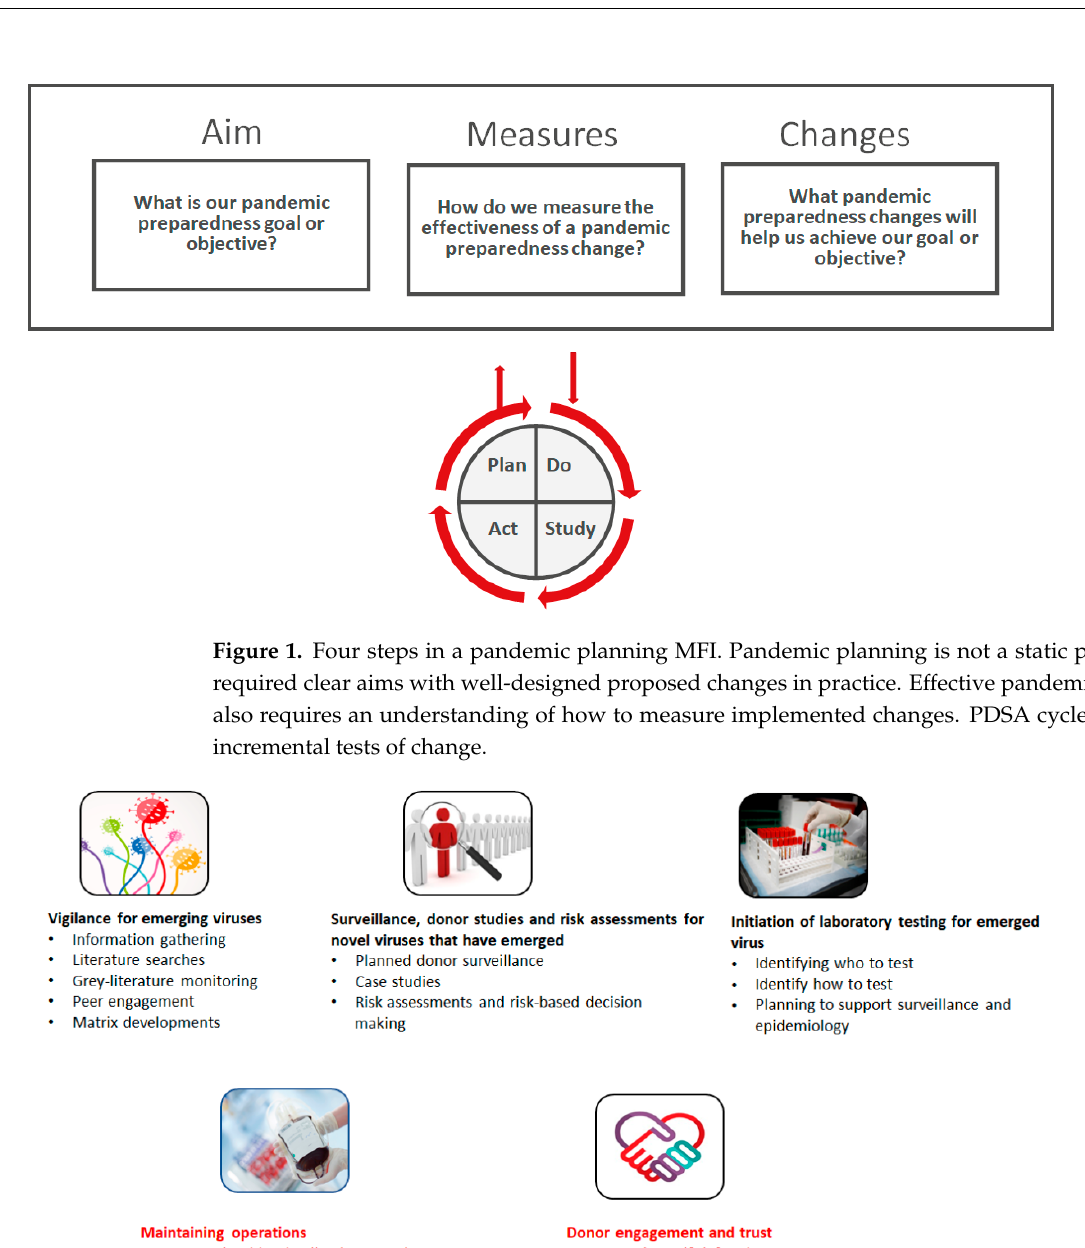
Figure 2. Activities that support pandemic preparedness. To ensure the safe supply of blood products, blood operators undertake complex activities on a routine basis. Pathogen-specific areas of focus (black text) include vigilance for emerging viruses, surveillance, donor studies and risk assessments for viruses that have emerged and initiating laboratory testing for emerging viruses. Core activities to ensure the adequate supply of blood products (red text) include donor engagement and trust, and maintenance of operations. Individuals working in blood operator settings may be engaged in one or more of these activity areas. Resources allotted to areas of focus may depend on a variety of factors including whether the emerging pathogen is transfusion-transmitted, or the level of disease spread in a donor population or work